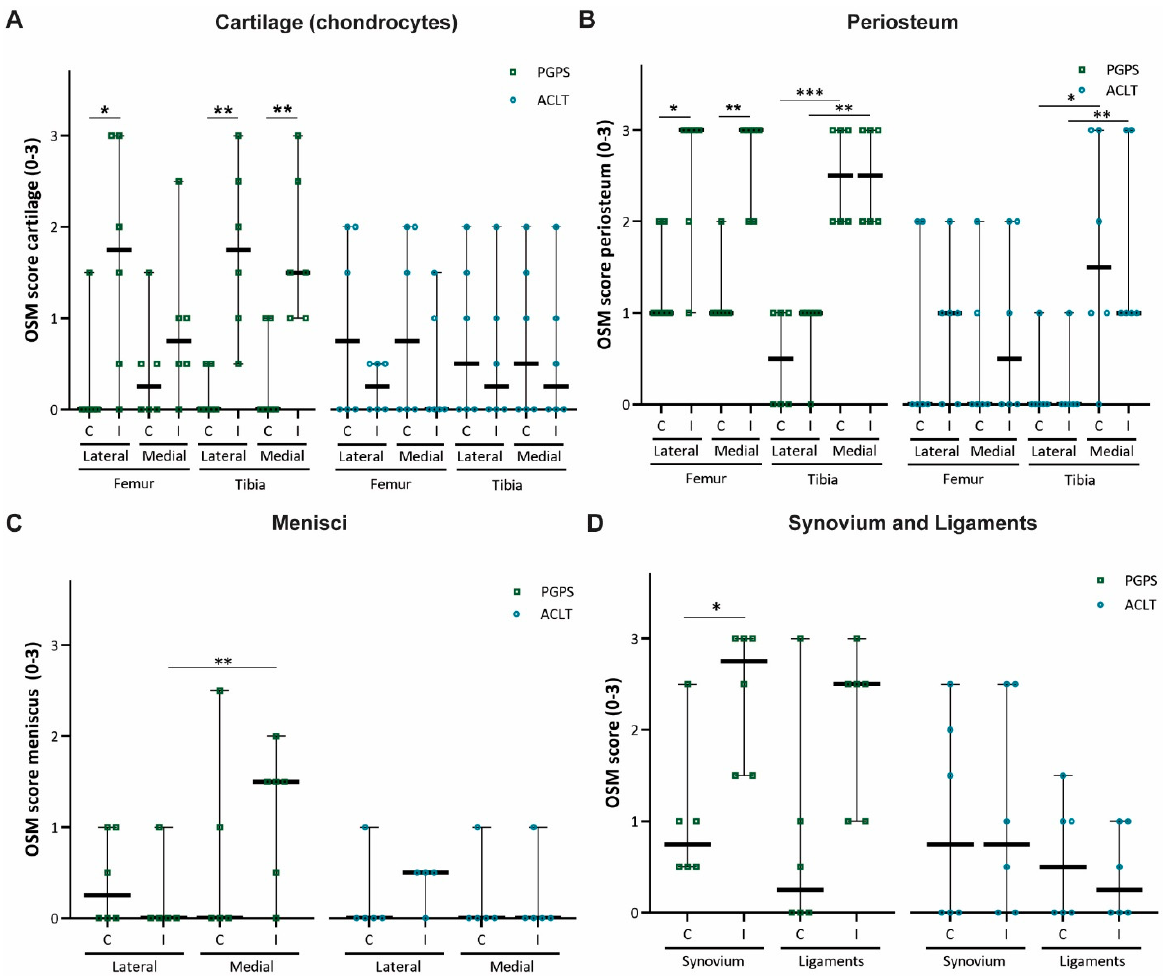
Figure 3. OSM expression scores in two rodent models of acute arthritis and instability induced OA. OSM score per anatomical structure: cartilage (chondrocytes) ( A ), periosteum ( B ), meniscus ( C ), synovium, and ligaments ( D ). Control (C), Induced (I). 0 = no staining, 1 = slight staining, 2 = moderate staining, 3 = extensive staining. Each individual datum point represents a rat knee. Squared symbols (green) refer to the PGPS model. Circular symbols (blue) refer to the ACLT model. Data are presented as median and 95% CI. (* p < 0.05, ** p < 0.01, and *** p < 0.001).